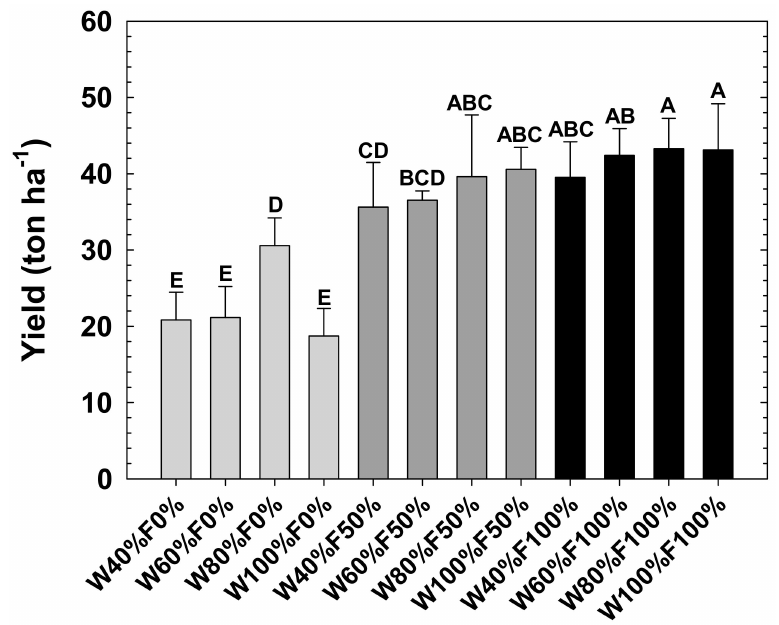
Figure 2. Potato tuber yield (ton ha − 1 ) as a function of irrigation and fertigation regime. Values with the same letter are not significantly different ( p < 0.05).